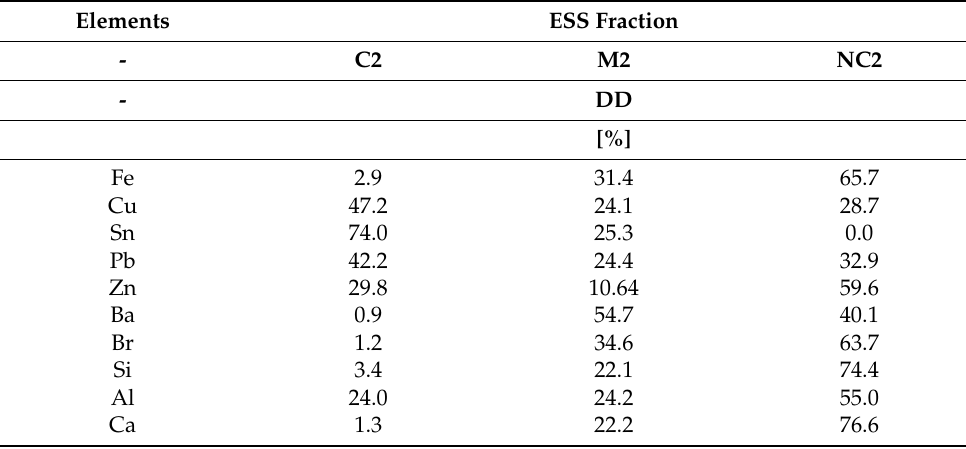
Table 12. Distribution of elements by fractions C2, M2, and NC2.